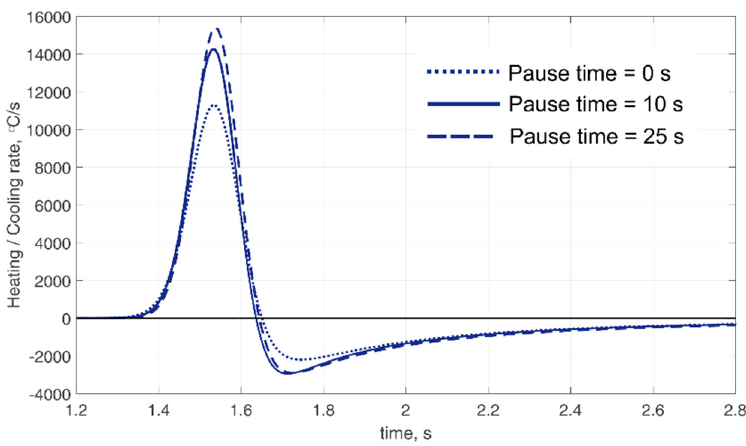
Figure 9. Calculated cooling rates during deposition of the 106th pass (outer bead).